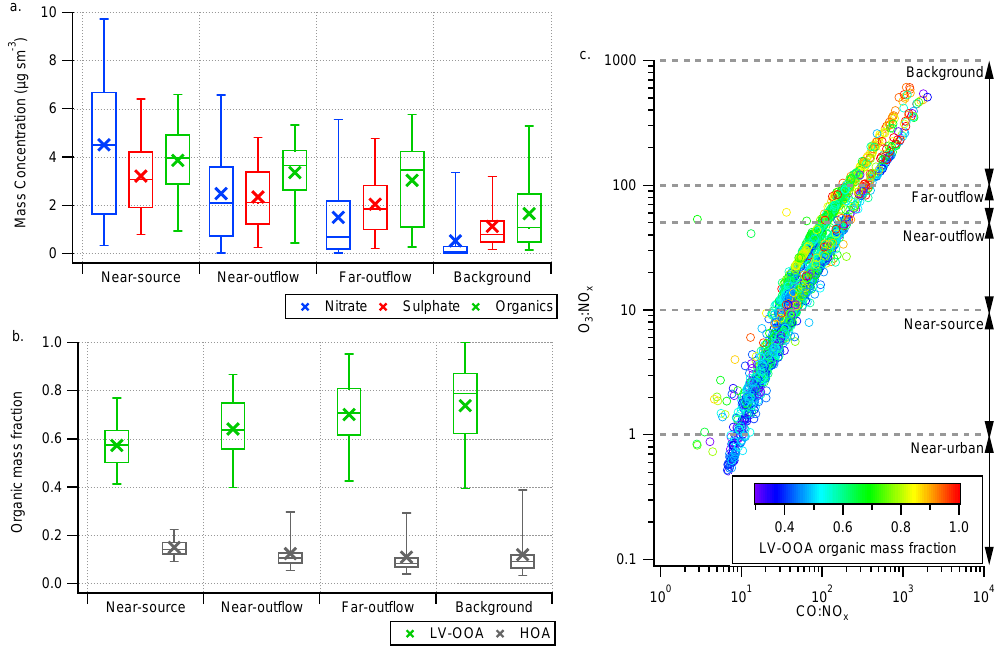
Fig. 7. Boxplot summary statistics of aerosol chemical composition as a function of proximity to source and photochemical processing. (a) Summarises the concentrations for nitrate, sulphate and organics, while (b) presents the organic mass fractions of LV-OOA and estimated HOA. Crosses represent the mean value, while horizontal lines represent the 25th, 50th and 75th percentiles. The whiskers represent the 5th and 95th percentiles. Values in (a) and (b) are for altitudes between 250–2500m. (c) Summary of the relationship between the O 3 :NO x ratio and the CO:NO x ratio for the dataset except for ADIENT-2 where no CO measurement was available. The grey horizontal lines designate the boundaries of the source proximities based upon the O 3 :NO x ratio which are used in (a) and (b). The points are coloured according to the LV-OOA organic mass